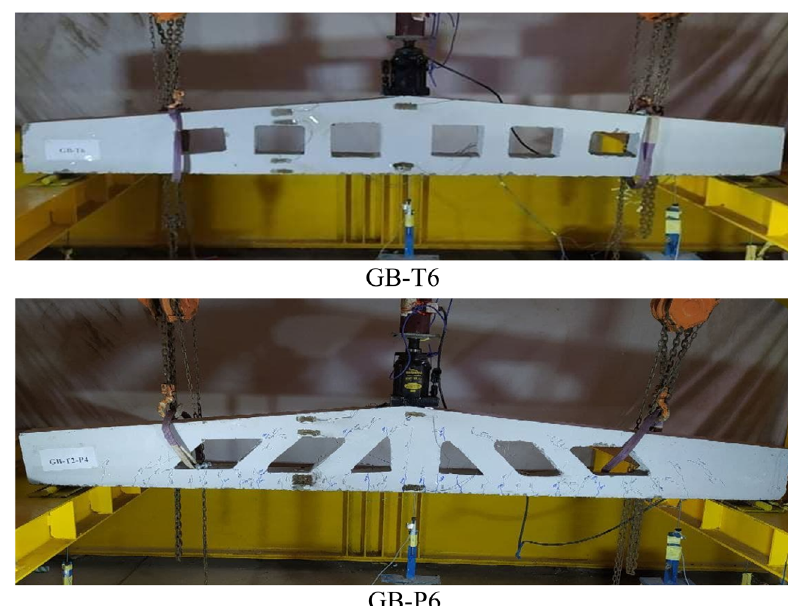
Figure 10: Tension - controlled fl exural mode